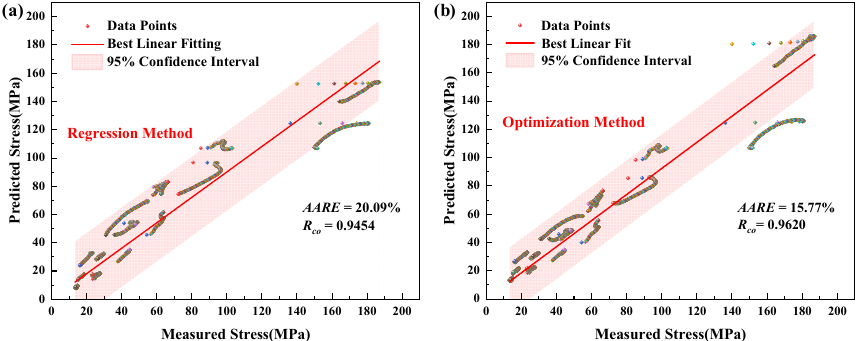
Figure 8. Correlation between measured and predicted stress of the modified Arrhenius-type model: ( a ) regression method; ( b ) optimization method.